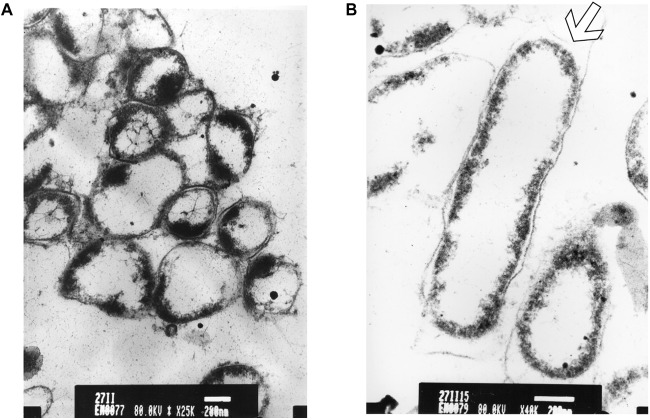
TEM micrograph of a full swarming area profile in thin section after 15 min of exposure (A) and at higher resolution (B). (A) Bars = 500 μm; (B) bars = 200 μm. This section reveals damaged cells with condensed cytoplasmic material (black dots) are visible. The arrow shows cytoplasm shrinkage in the cell pole.